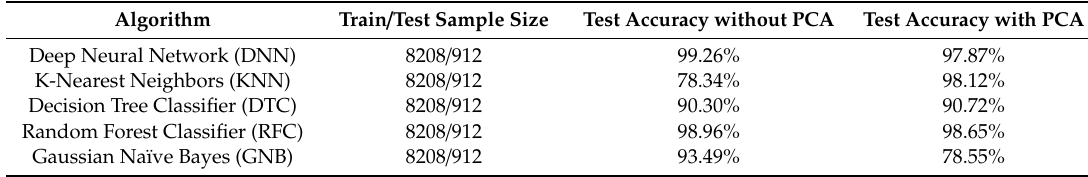
Table 1. Baseline test accuracies using k-fold (k =